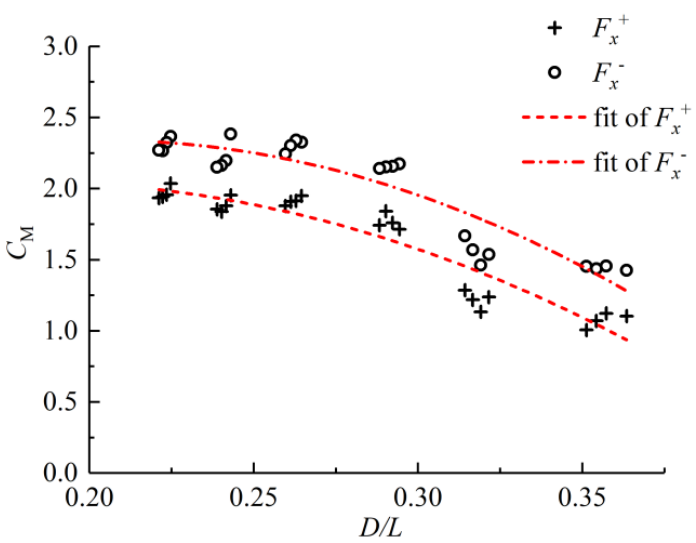
Figure 8. Regression analysis of the inertial coefficient.